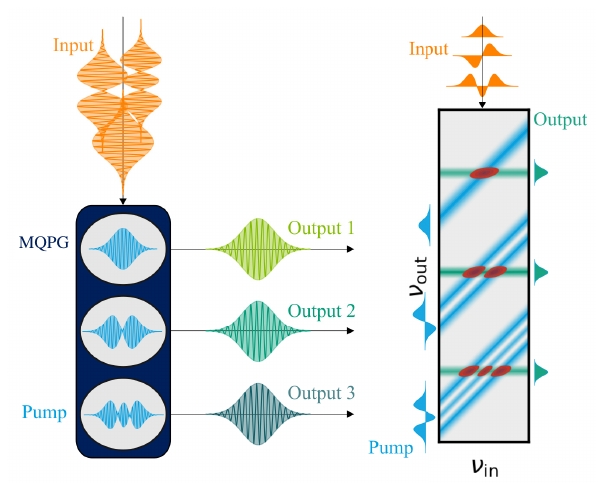
FIG. 1. The working principle of the MQPG (left) and descrip- tion in frequency space (right): in the MQPG waveguide, the input photons (orange) are demultiplexed to different output fre- quencies (green) on the basis of their TM. The TMs to be measured are selected by shaping the pump field